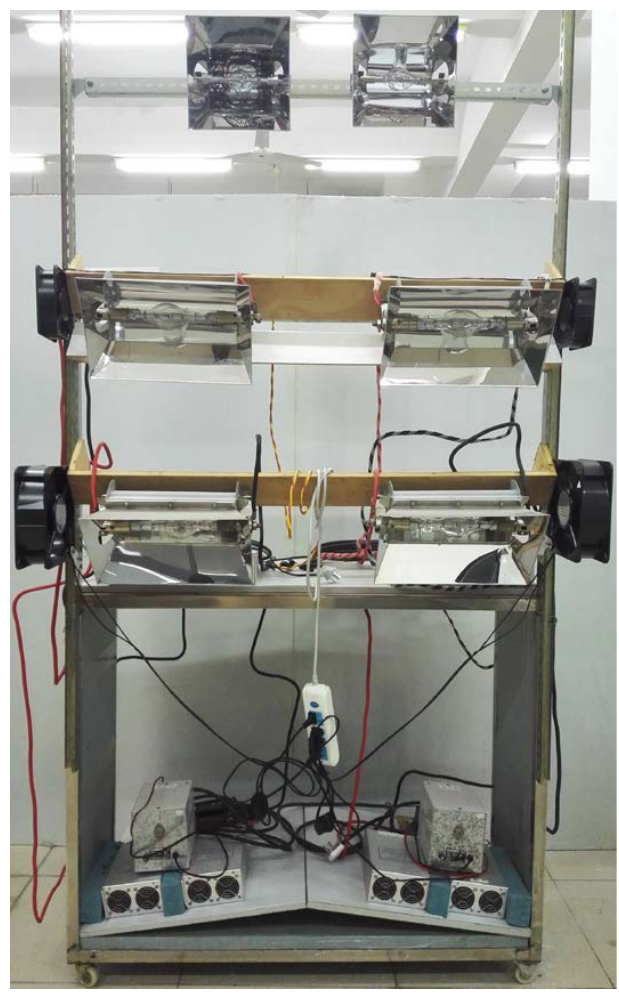
Figure 5. Image of the xenon lamps.